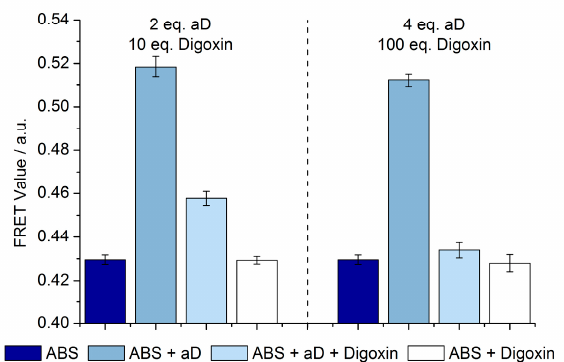
Figure 3. Addition of free digoxin to the digoxigenin assays. The FRET values for overnight analysis of anti-digoxigenin antibody (aD) and digoxin with the strand displacement competition (SDC) assay (20 nM, A:B:S = 1:1:1). The assay shifted from lower FRET to higher FRET when aD (40 or 80 nM, 2 or 4 eq. (equivalents)) was present, and it shifted back when digoxin (200 or 2000 nM, 10 or 100 eq.) was present as well. Three samples for each measurement (six for ABS). Plotted values are mean values with standard deviations compared to the mean value. All samples were incubated overnight before measuring.